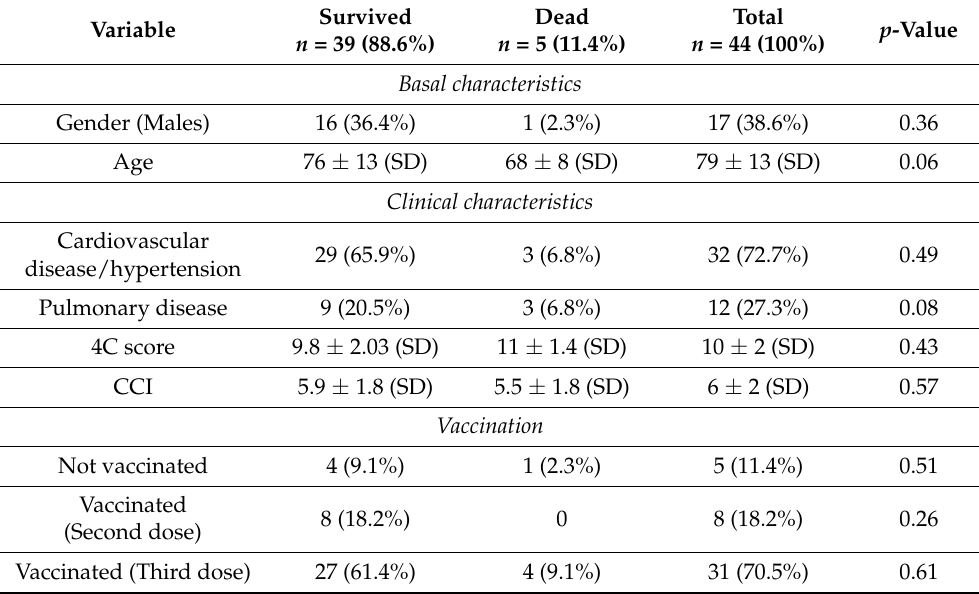
Table 3. Patients’ characteristics distributions between dead and survived patients.